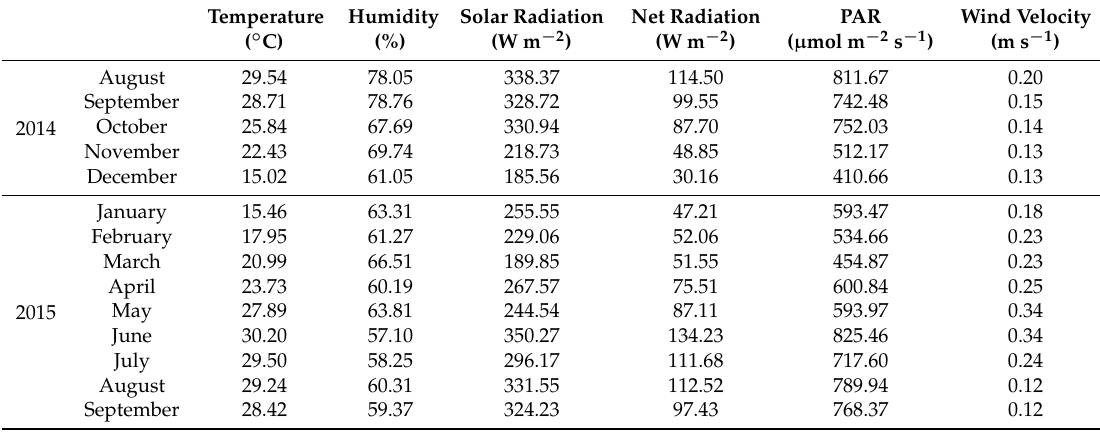
Table 2. Monthly mean value of the meteorological parameters in the study